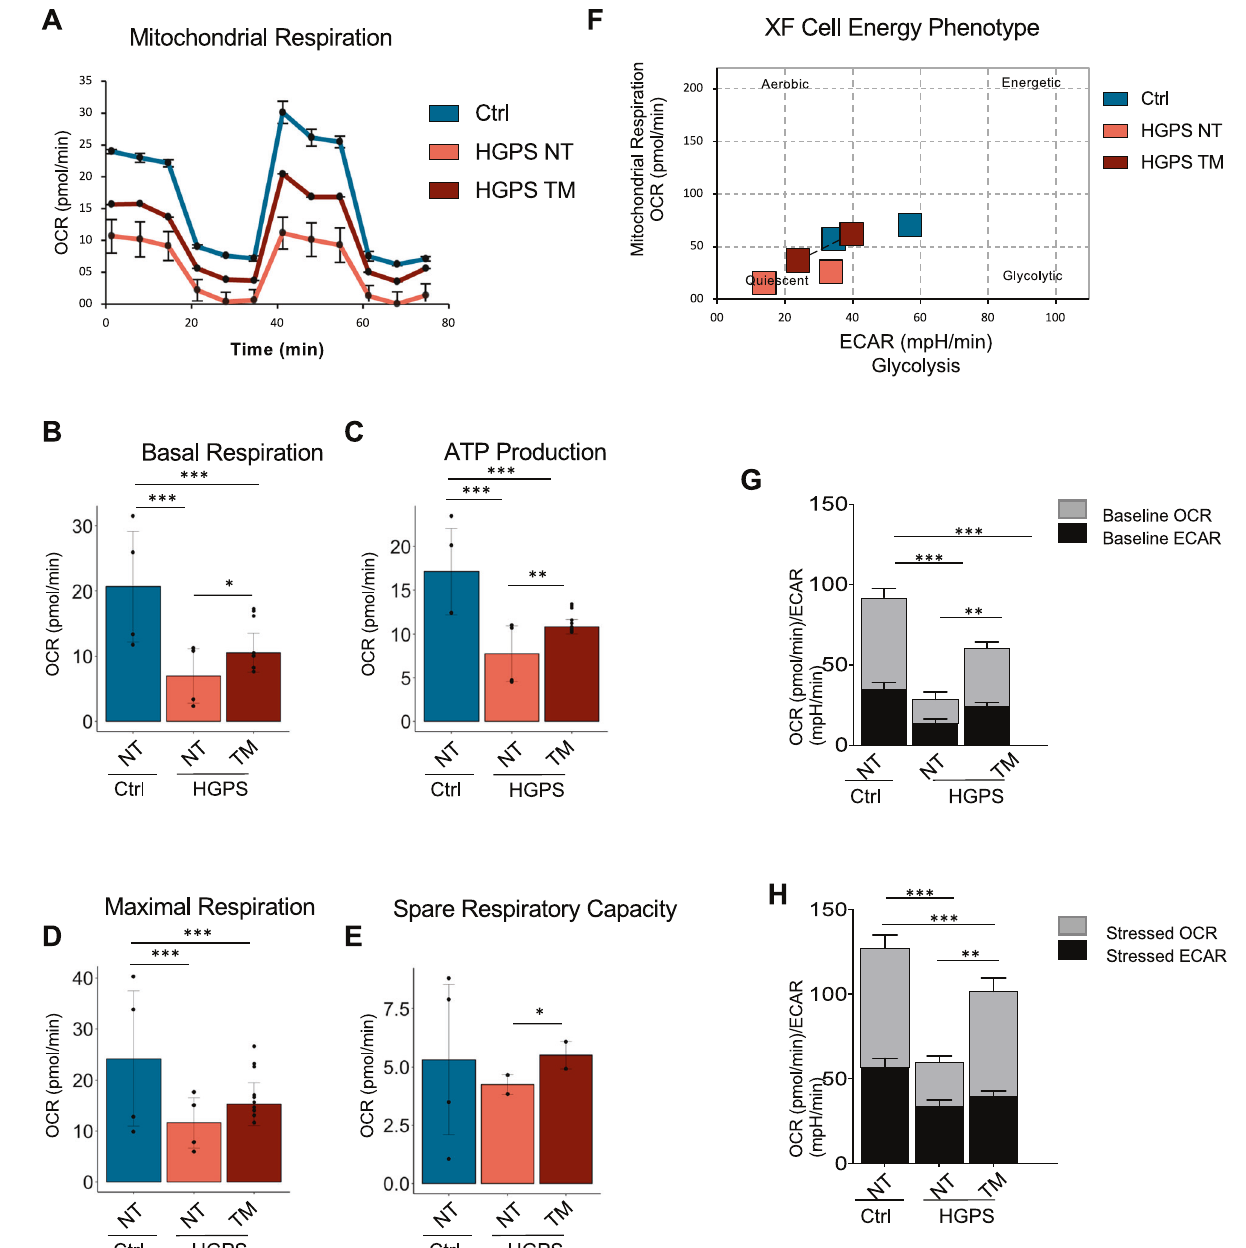
Fig. 5 TM5441 treatment improves energy metabolism of HGPS. A Representative data graphic of oxygen consumption rate (OCR) obtained from the Cell Mito Stress Test. Mitochondrial respiration expressed as normalized OCR of control, HGPS and HGPS TM5441-treated cells after the sequential addition of oligomycin, FCCP, rotenone and antimycin as indicated. B The basal respiration which represents the oxygen consumption used to meet cellular ATP demand in resting condition. C Mitochondrial ATP production, calculated as the OCR difference between the baseline and after the addition of oligomycin. D The maximal respiration measured as the maximal oxygen consumption rate attained by adding the uncoupler FCCP. E The spare respiratory capacity obtained from the analysis of the Maximal respiration. F The cellular energy diagram showing the normalized oxygen consumption rate (OCR) and the normalized extracellular acidi fi cation rate (ECAR) of control, HGPS and HGPS TM5441-treated cells at baseline and stressed conditions. G , H Metabolic potential of control, HGPS and HGPS TM5441-treated fi broblasts was calculated from unstressed G and stressed ( H ) OCR/ECAR over baseline. 30 min. PA was then visualized by placing the TritonX-100 plasminogen, and the absorbance generated at 405 nm, related washed gel on a casein-agar-plasminogen underlay, as pre- to PA activity, was normalized to cells present in the culture viously described [60]. All the bands were plasminogen dish. To characterize the type of PA present in the samples, dependent. PAI-1 was detected by reverse zymographic assays. aliquots of conditioned medium were separated by 10% sodium 0.05 U/ml human urokinase (Serono, Denens, Switzerland) was dodecyl sulfate polyacrylamide gel electrophoresis (SDS-PAGE) added to the casein-agar-plasminogen underlay as previously under non-reducing conditions. After electrophoresis, gel was described [61]. Molecular weights were calculated from the washed in 2,5% TritonX-100 for 30 min and then in water for Cell Death and Disease (2022)